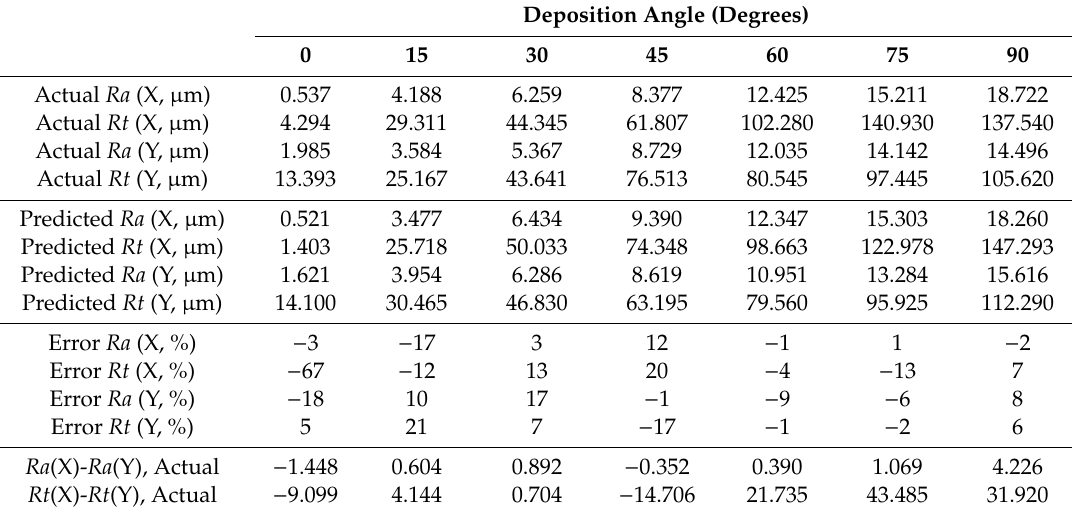
Figure 6. Plot lines for the regression models: ( a , b ) X direction; ( c , d ) Y direction. Table 1. Measurements: Actual and predicted values.